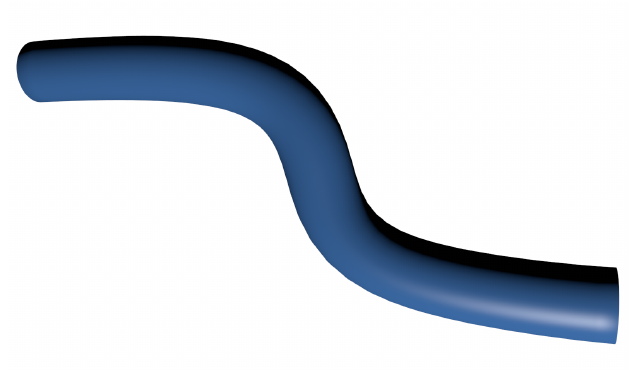
Figure 3. Curved pipe model used in the sensitivity analysis.